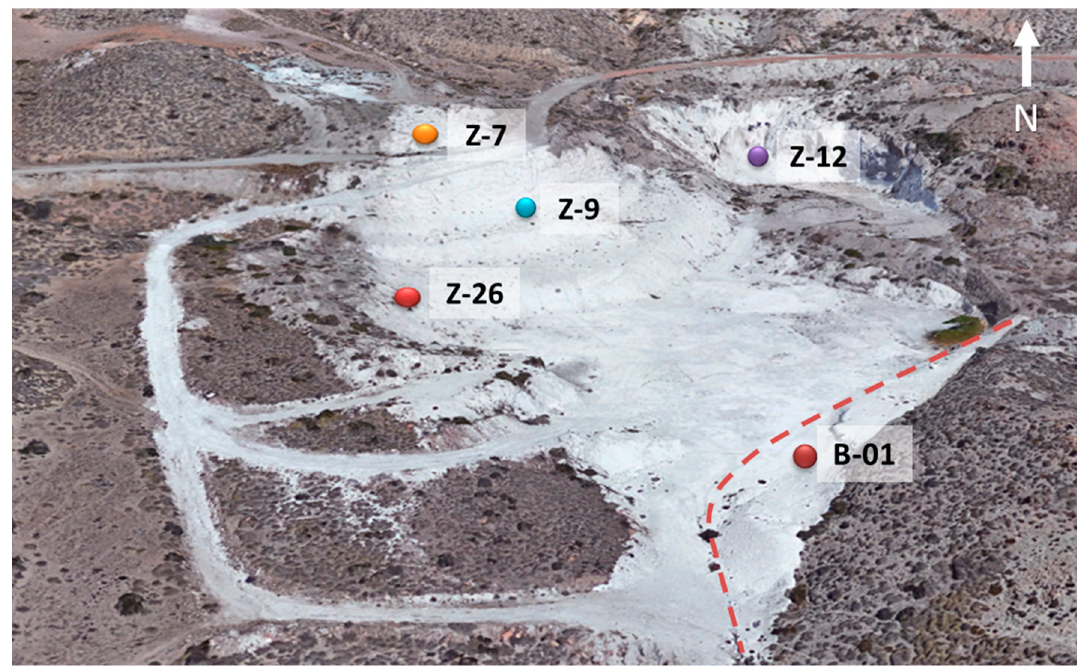
Figure 1. Photograph of the San José-Los Escullos deposit (google earth) where the natural mordenite samples are collected, the actual location of each collected sample is indicated.